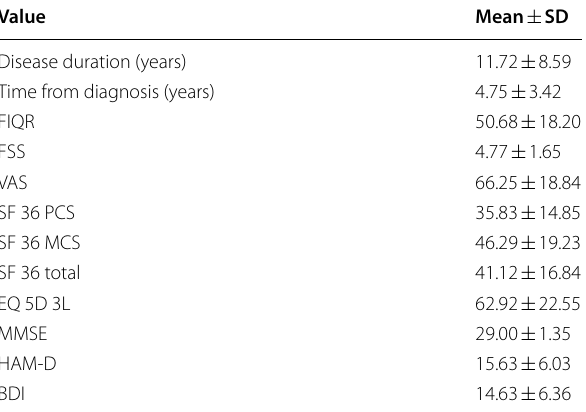
Table 1 Demographic and Clinical features of fibromyalgia patients (n =